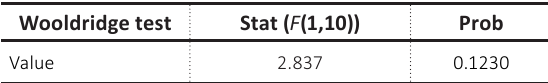
Table 9. Wooldridge autocorrelation test